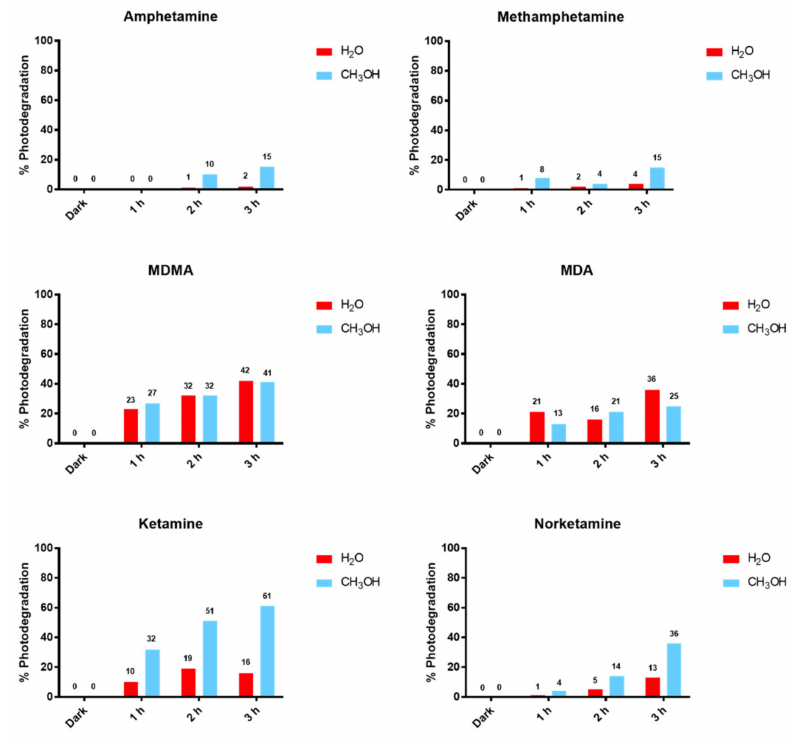
Figure 4. Relative degradation of target drugs in methanol and water solutions with increasing time of irradiation in the solar simulator (% photodegradation calculated using the peak area of protonated molecules in solutions kept in the dark as controls for 0%